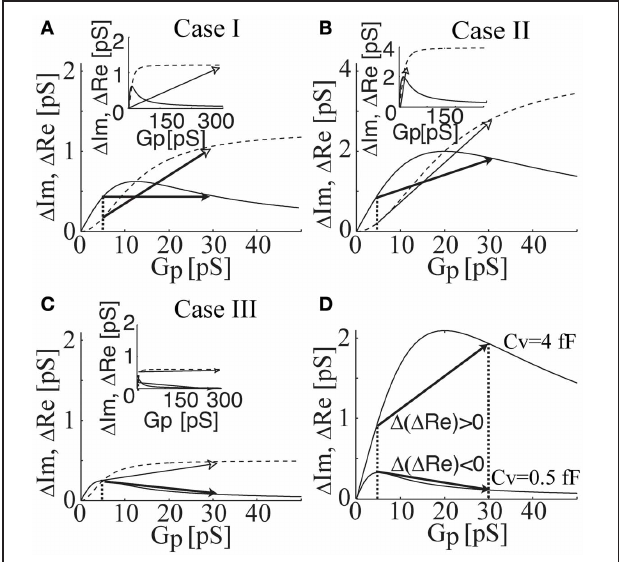
FIGURE 4 | The relationships of (cid:2) Re (solid lines) and (cid:2) Im (dahsed lines) as a function of G p calculated for intermediate ( C v = 1 . 2fF; case I), large ( C v = 4fF; case II), and small ( C v = 0 . 5fF; case III) vesicle size. Note that the change in (cid:2) Re and (cid:2) Im are drawn by a full and an open arrow, respectively. The zero projection on the Re part is reproduced by a change from a fully closed state to a fully open fusion-pore state (see inset) or by a change from a nearly closed state to an incompletely open fusion-pore state (A) . The incremental projection in case II is reproduced by a change from nearly closed to incompletely open state (B) . The decremental projection in case III can be reproduced, only when the pre-fused state is nearly closed (C) . In addition, the change in (cid:2) Re can be considerably larger than the change in (cid:2) Im (see inset). Overlay of (cid:2) Re ( Gp ) of cases I and III reveals the effect of vesicle size on the projection type (D) . By having the same pre-fused state (i.e., the same fusion pore conductance), the incomplete fusion-pore opening of a large vesicle size leads to an incremental projection, whereas, the same incomplete opening of a small vesicle causes a decremental projection in Re